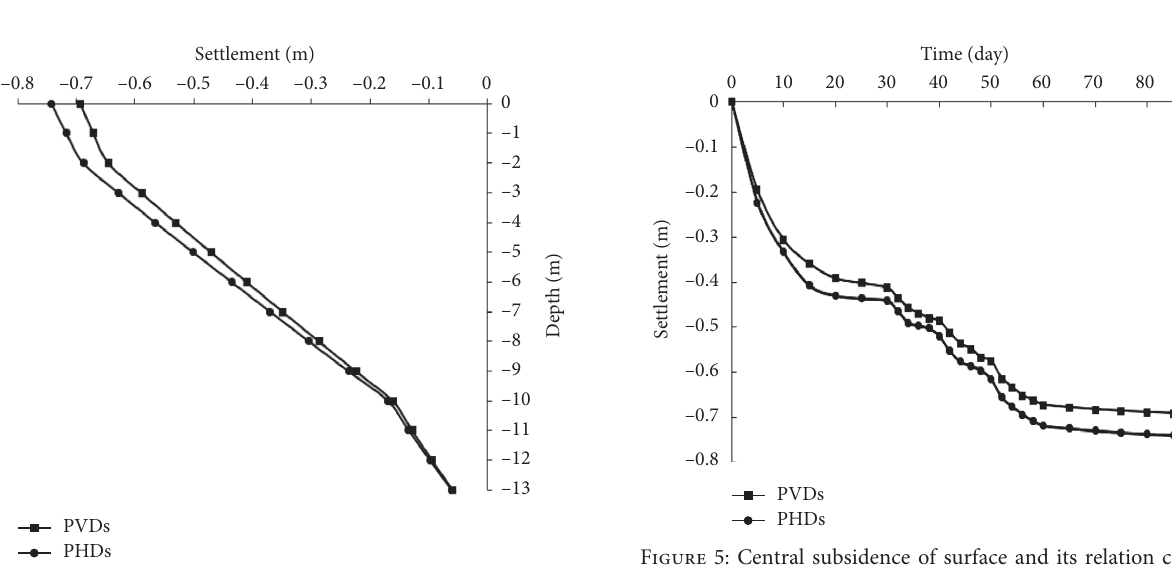
Figure 4: Relationship curve between depth and final settlement.